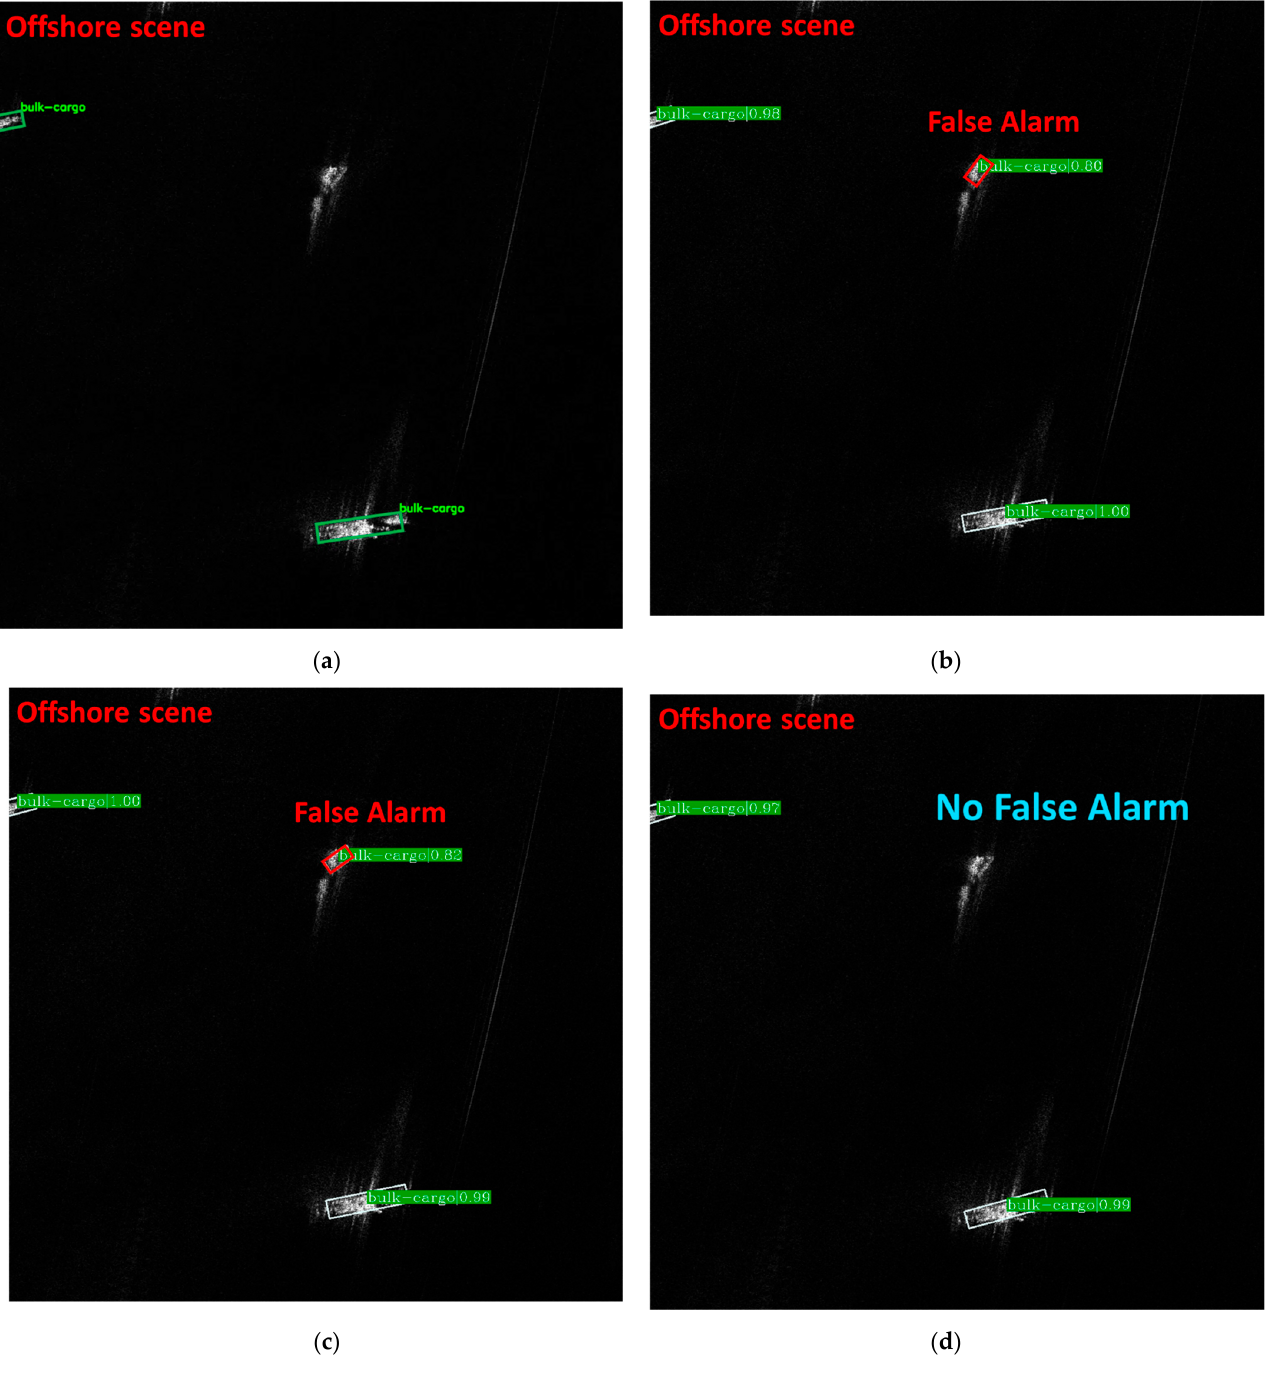
Figure 12. Detection results in offshore scenes. ( a ) Ground truth; ( b ) Result of ROI; ( c ) Result of O-RCNN; ( d ) Result of RBFA-Net.